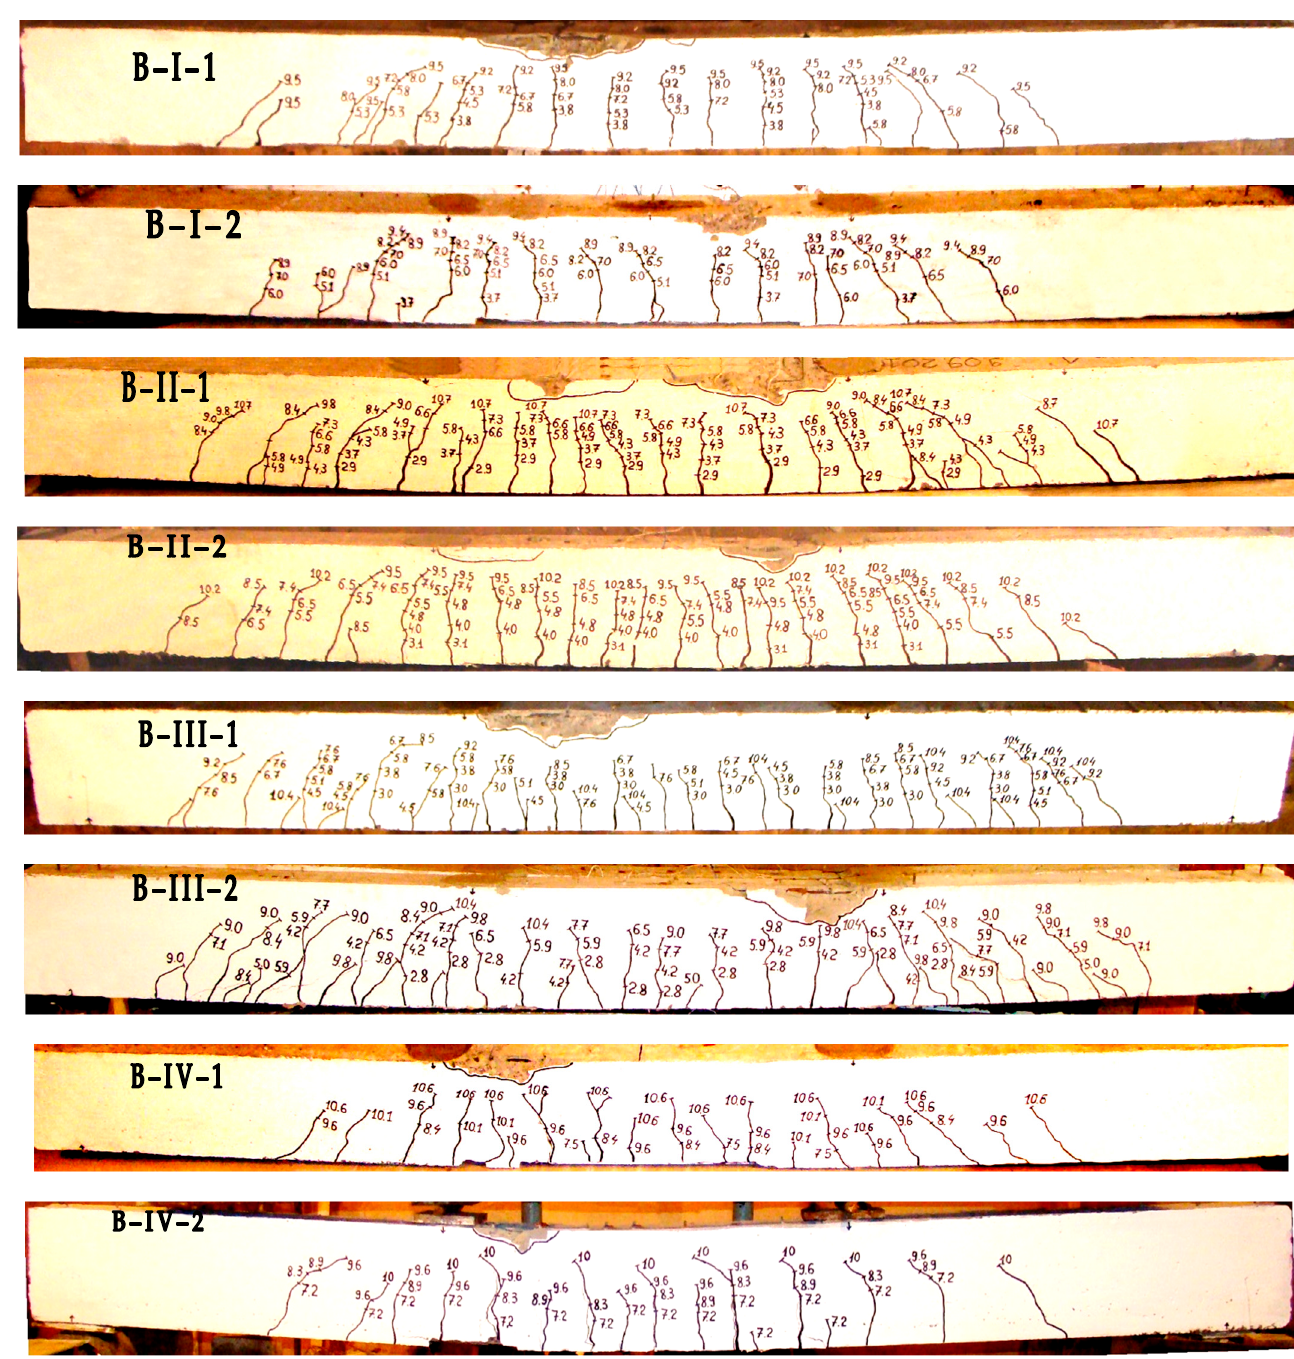
Figure 7. Specifics of beam